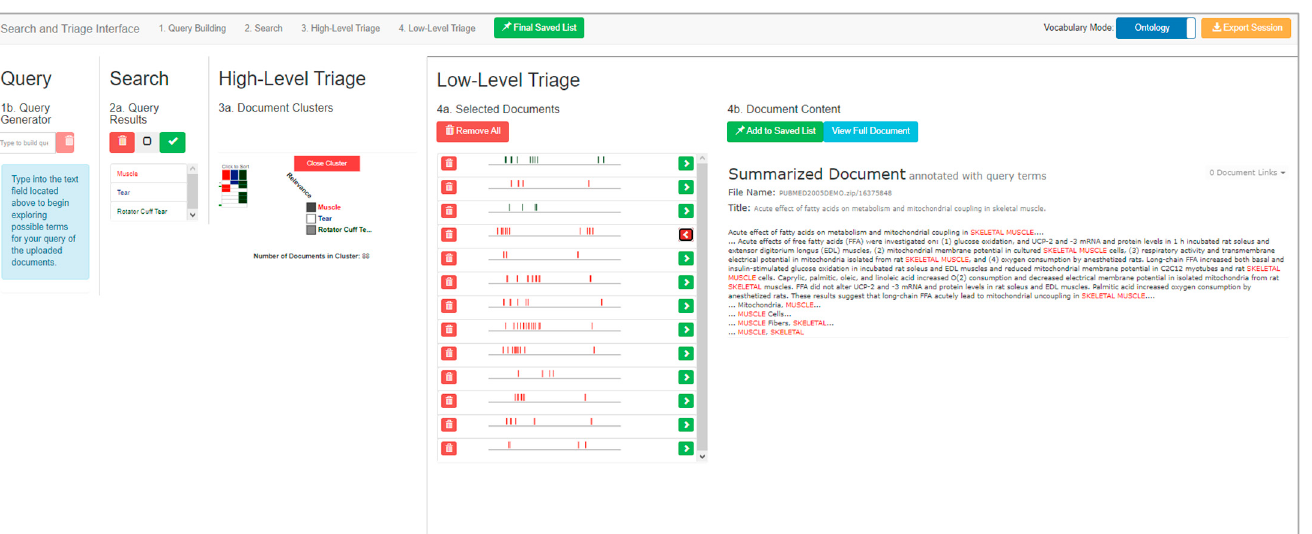
Figure 14. A closer view of the Selected Documents listing, where the user can see timeline-like abstraction of documents and their alignment with the search formulation. In this visual abstraction, colored marks are placed along a timeline to reflect the po- sition of words or phrases which align with the query items of the search formulation. Documents with strong alignment will produce numerous markings, resulting in color-